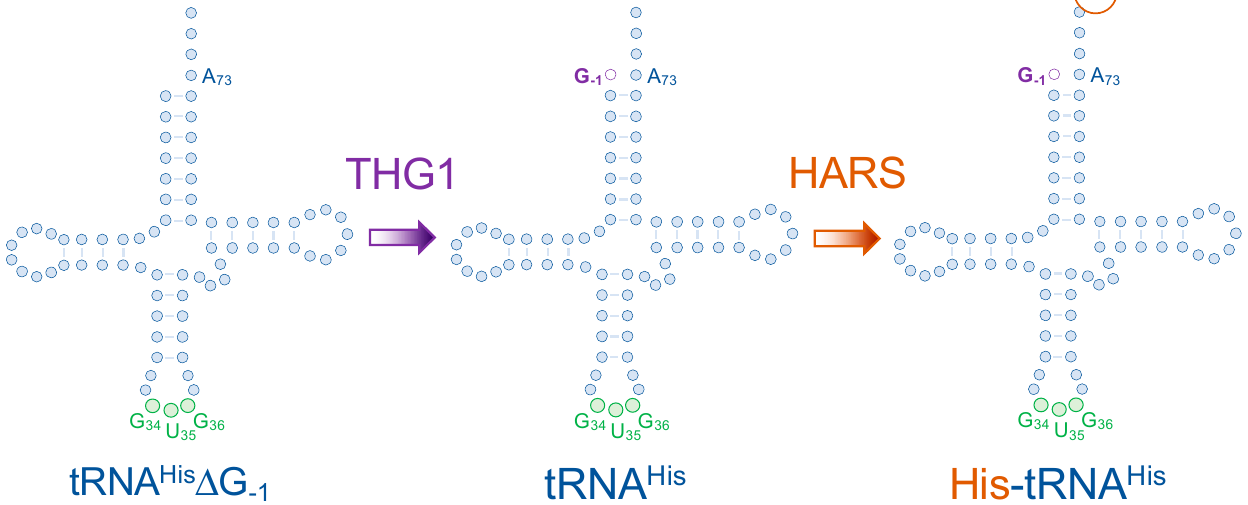
Figure 3. The post-transcriptional addition of the tRNA His identity element (G − 1 ) by tRNA His guan- ylyl transferase (Thg1). Processing of the 5 ′ end of tRNA His by RNase P leads to the formation of tRNA His ∆ G -1 . tRNA His guanylyl transferase (Thg1) inserts a guanylyl residue at position − 1, opposing to A 73 in eukaryotes to form mature tRNA His . G -1 is the identity element in which histidyl tRNA synthetase (HARS) recognizes tRNA His for aminoacylation to form His-tRNA His